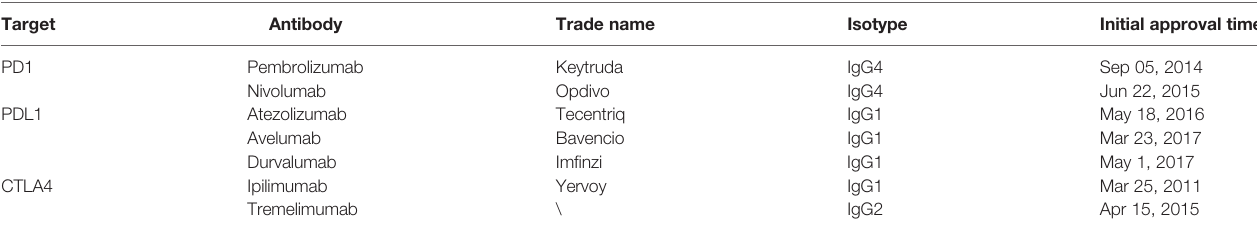
TABLE 1 | Summary of immune checkpoint-targeting